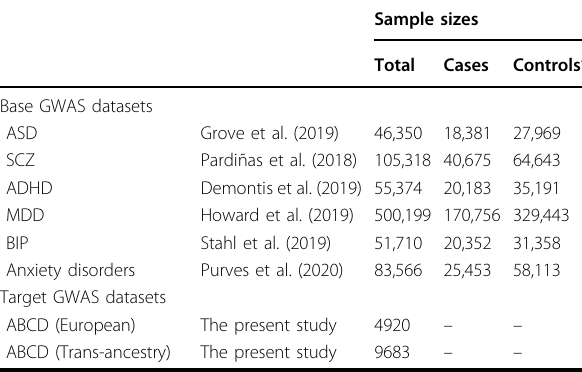
Table 1 Sample sizes for the base and target